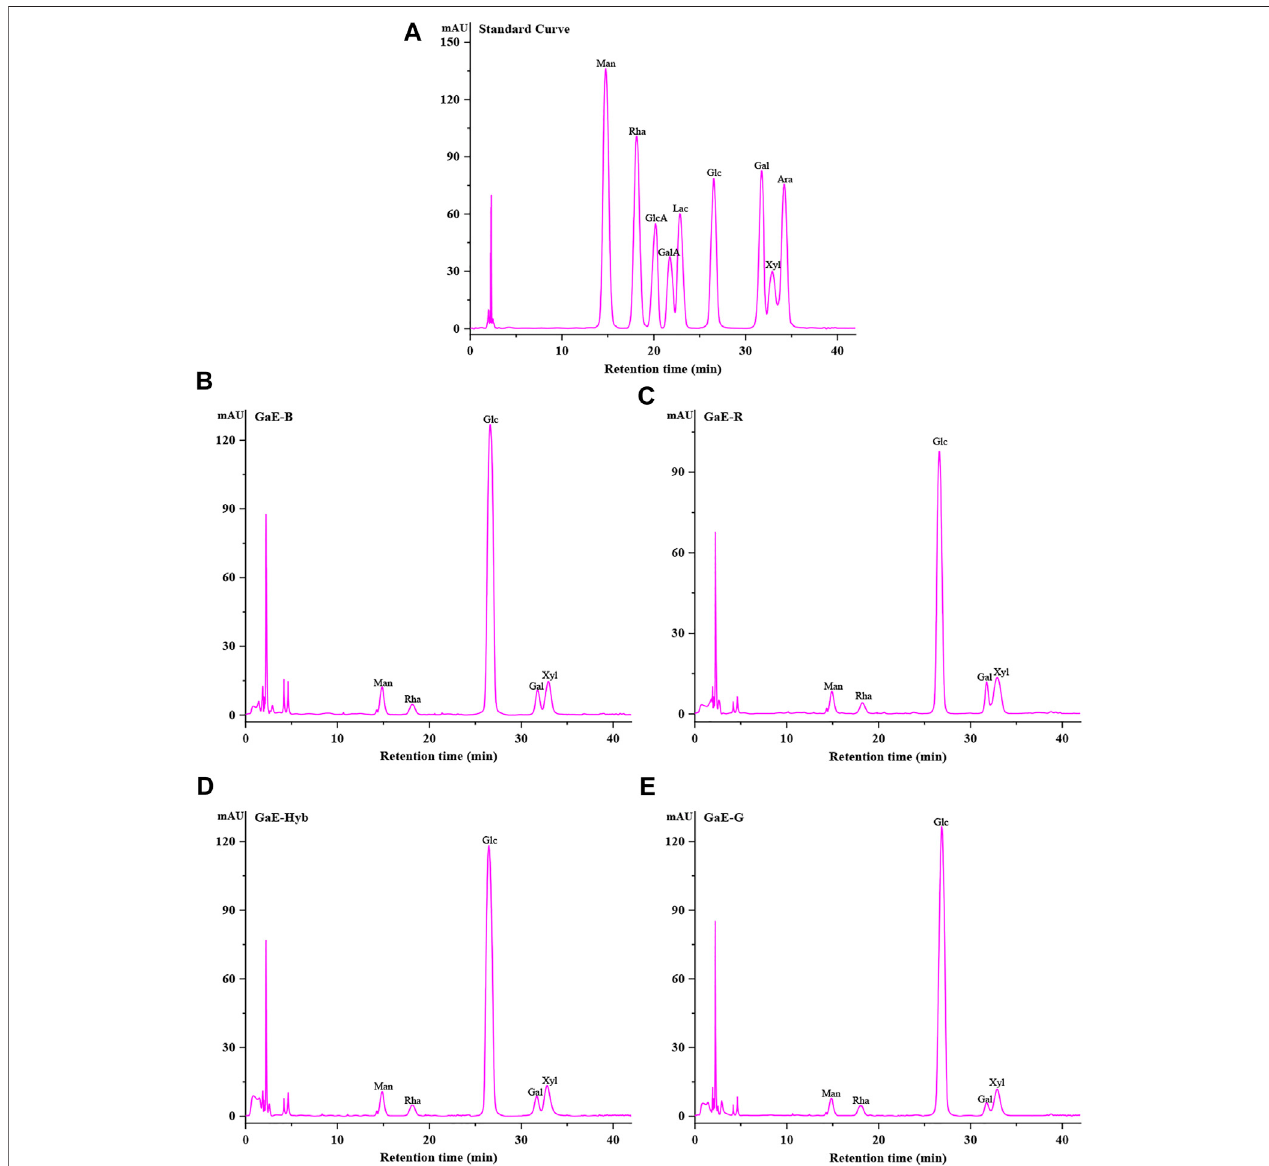
FIGURE1| Monosaccharidecompositionofthepolysaccharidewithfourdifferentvarietiesof Gastrodiaelata . (A) Standardcurve; (B) GaE-B; (C) GaE-R; (D) GaE- Hyb; and (E) GaE-G.